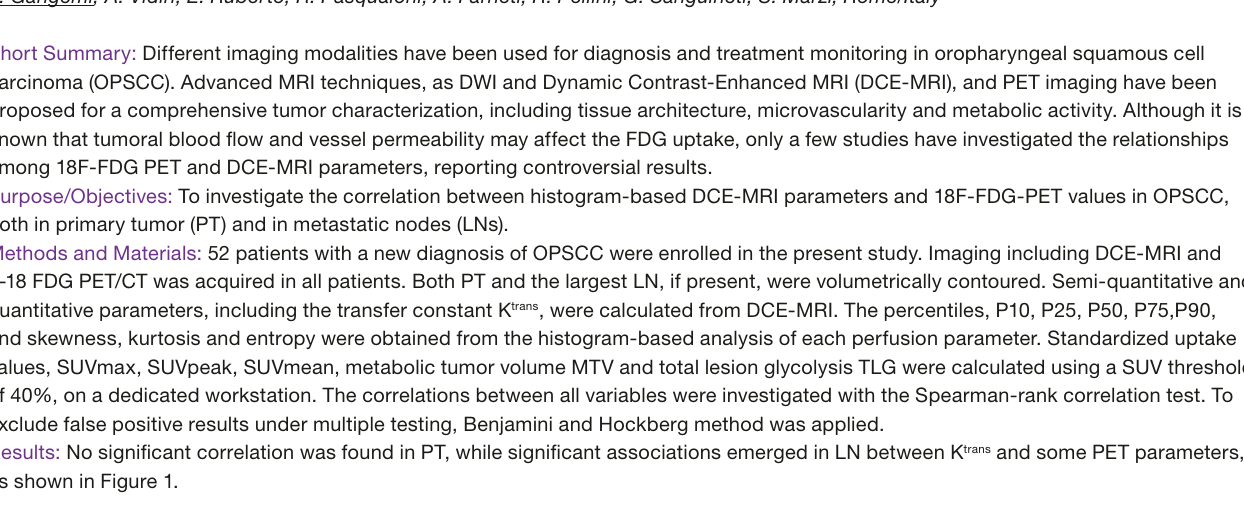
Figure 1: Spearman-rank correlation test between K trans and PET parameters in LN